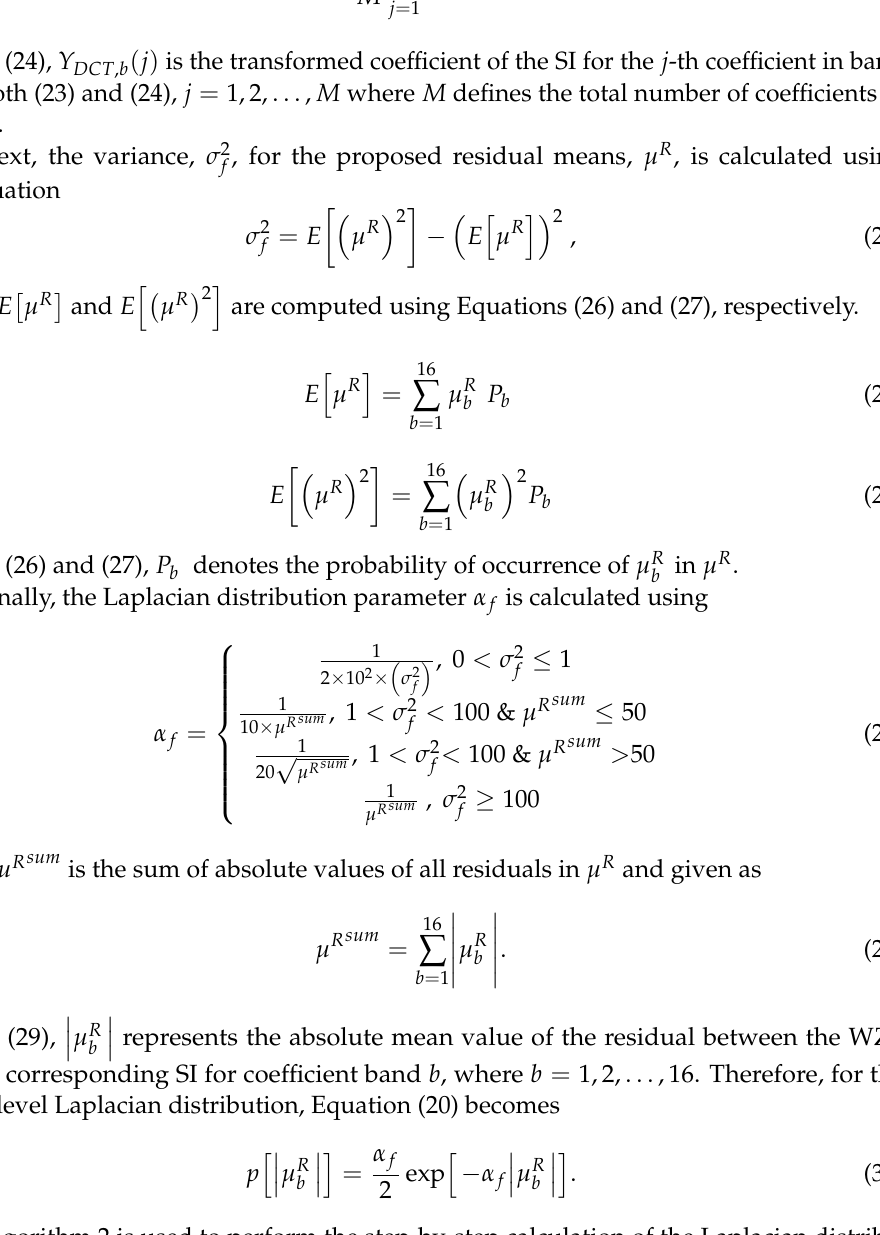
Algorithm 2 is used to perform the step-by-step calculation of the Laplacian distribu- tion parameter α f under the proposed CNM methodology. The process starts by